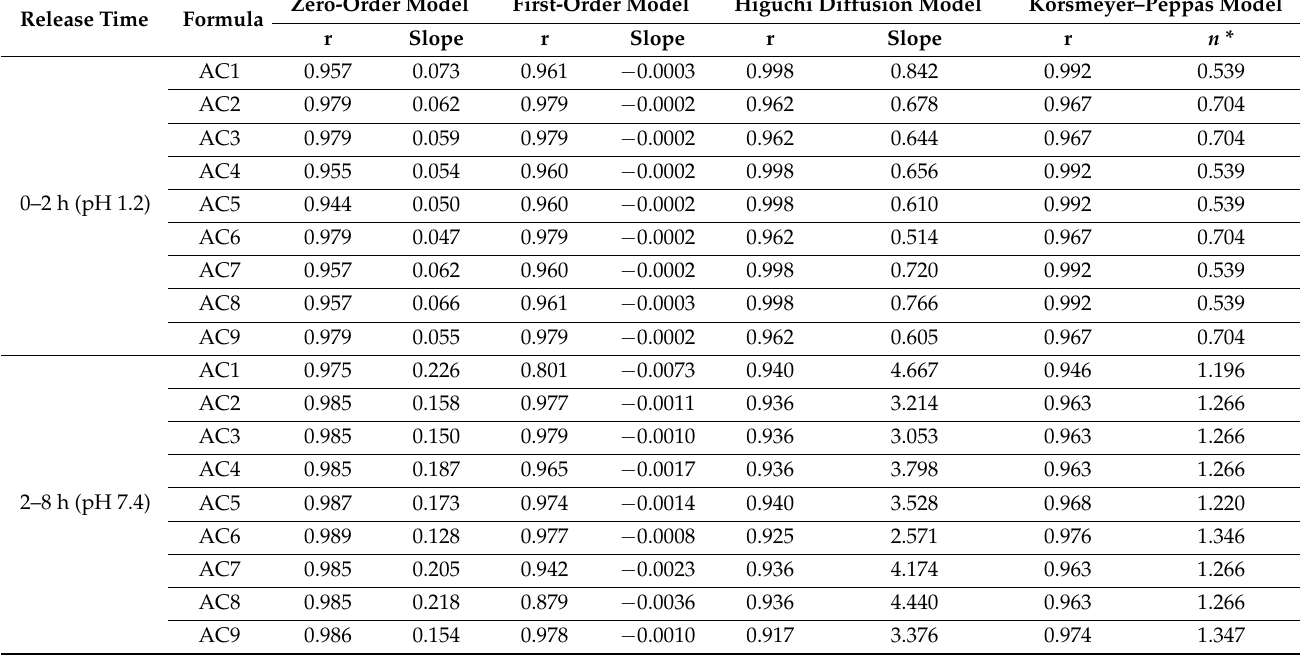
Table 4. Kinetic modeling of the release of AC from sustained-release matrix pellet formulations at pH 1.2 and pH 7.4. Release Time